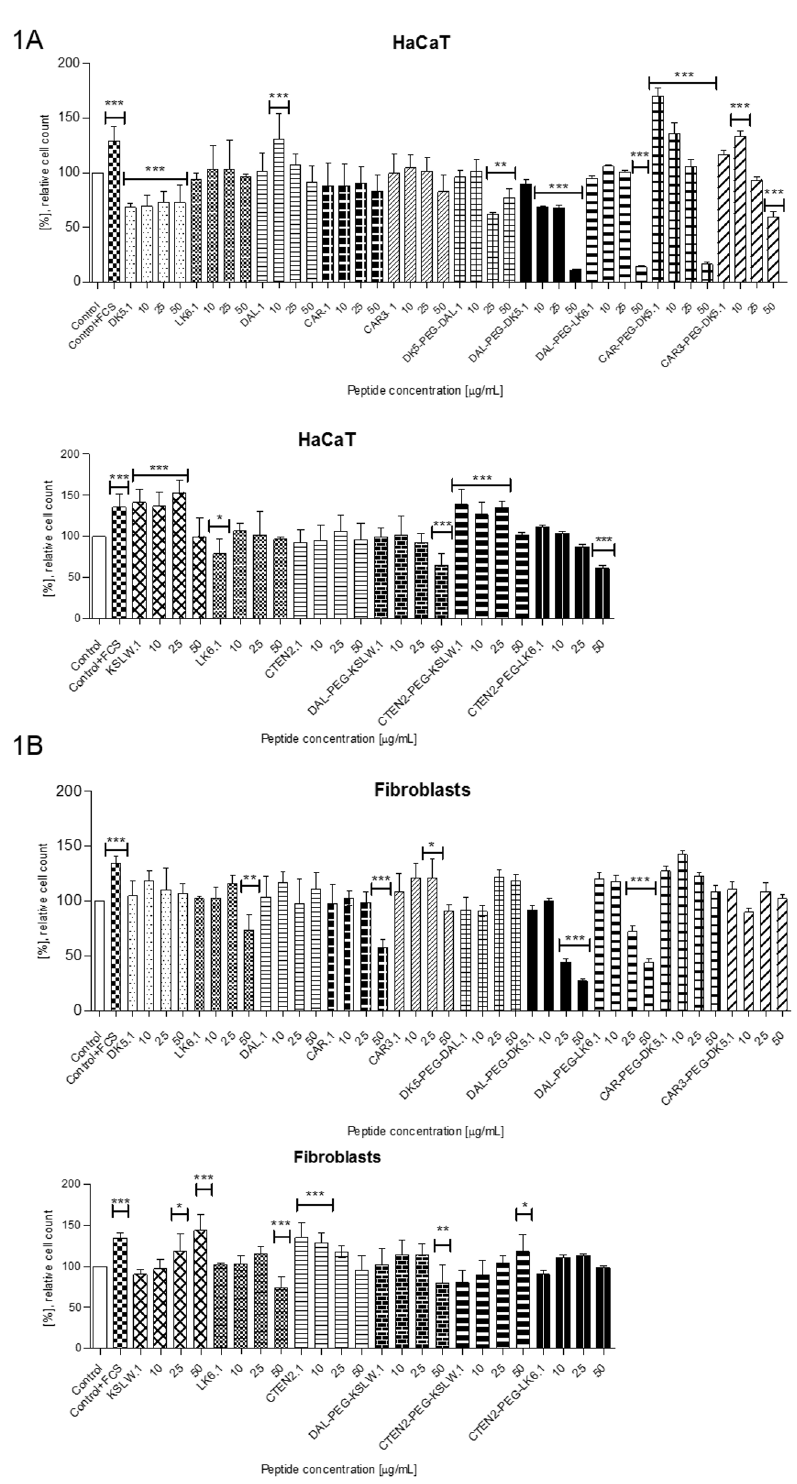
Fig 1. Pro-proliferative activity of the tested peptides towards human keratinocytes (A) and fibroblasts (B). Cells were incubated for 72 hours in serum-free DMEM medium in the presence of peptides applied at concentrations of 1,10, 25 and 50 μ g/mL, respectively. The data represents results of MTT assay expressed as the percentage of the cell viability in comparison to their control sample (cells incubated in serum-free DMEM without tested peptides), additional positive control corresponds to the cells incubated in